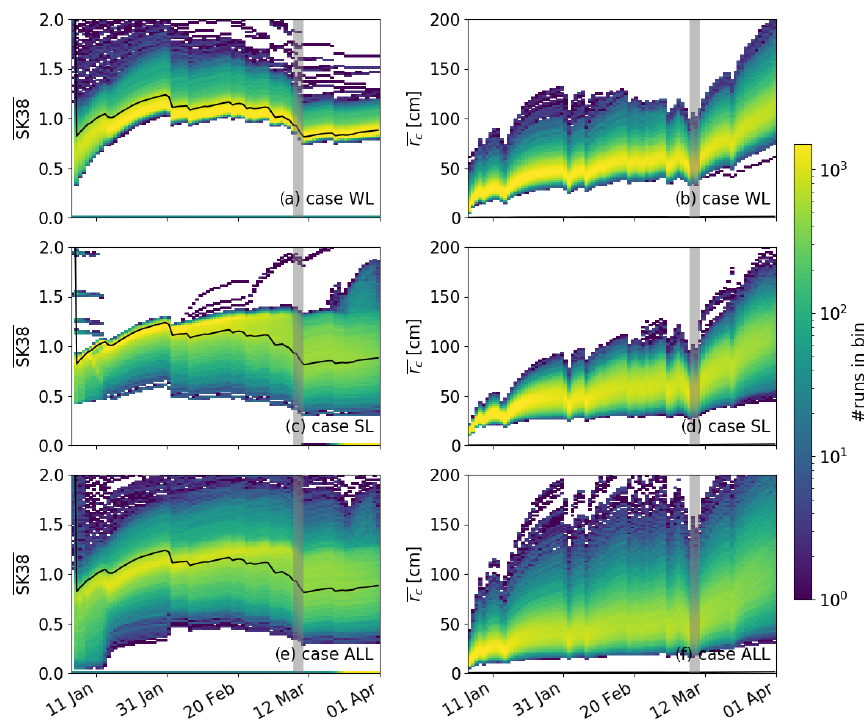
Figure 7. Temporal evolution (January to March 2017) of input uncertainties to modeled skier stability index SK38 for (a) case WL, (c) case SL and (e) case ALL and critical crack length r c for (b) case WL, (d) case SL and (f) case ALL. Colors indicate the binned number of simulations. Black lines show the reference run and grey vertical bars highlight the period of high avalanche activity.